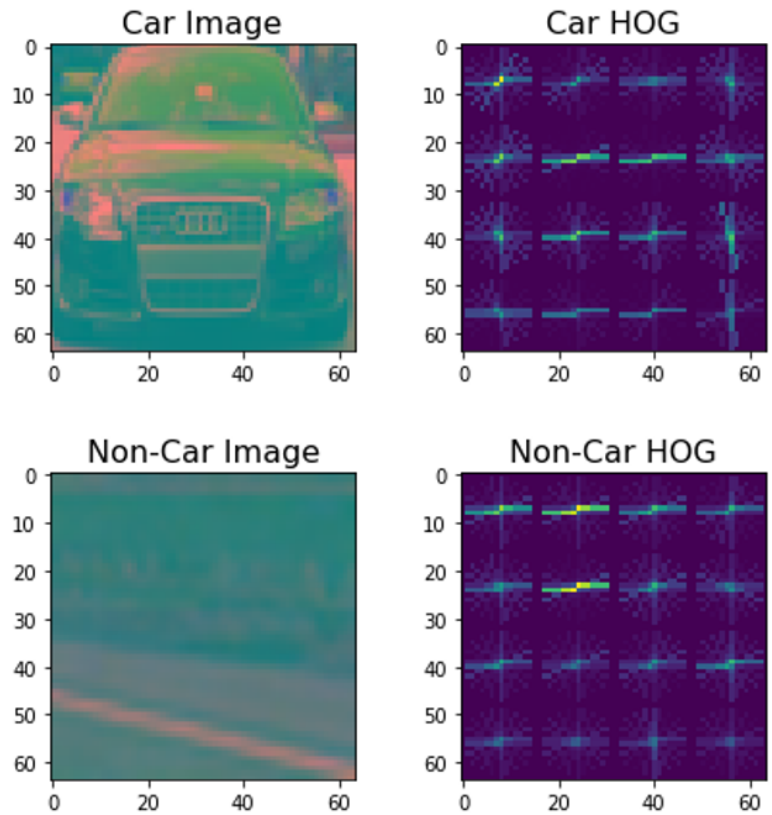
Figure 7. Example of HOG feature extraction for the vehicle and non-vehicle